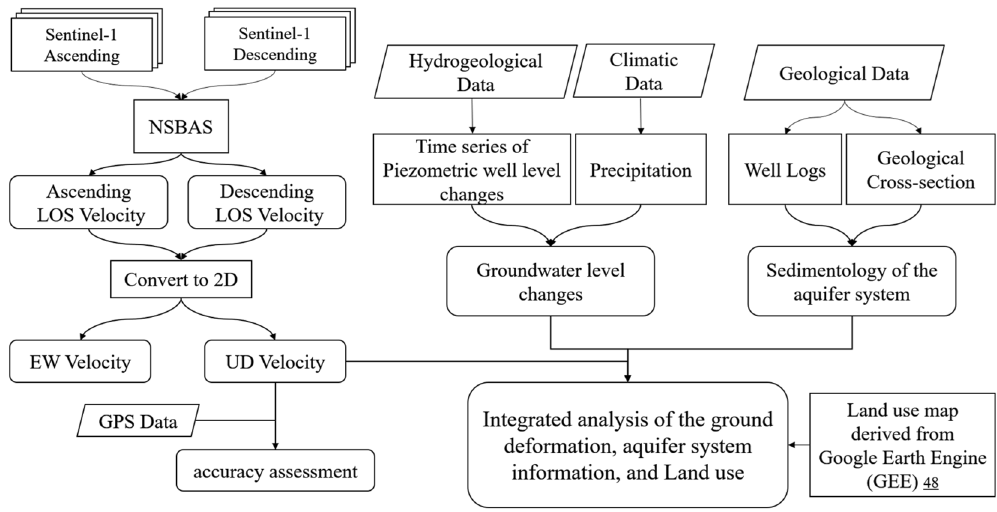
Figure 5. Processing and analysis steps for the data used in this study.